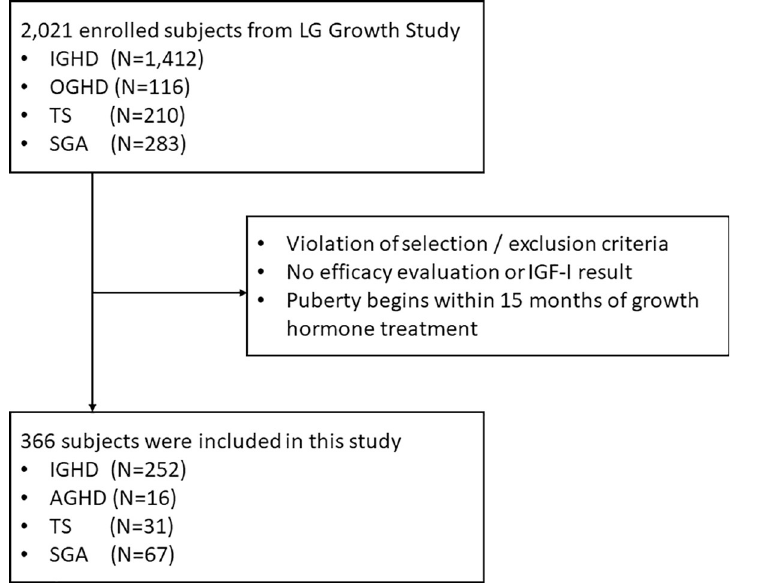
Fig 1. Flow chart of subject inclusion in this